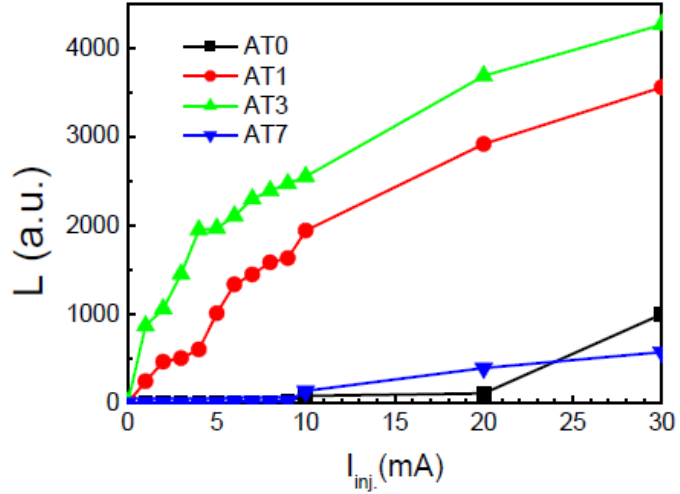
Figure 7. The luminescent intensity (L)-injection current (Iinj.) characteristics for diode AT0, AT1, AT3, and AT7.